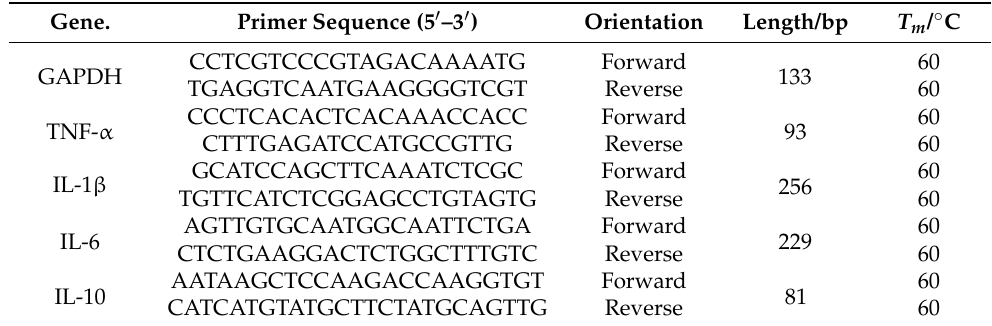
Table 1. Primer information of targeted genes and GAPDH.